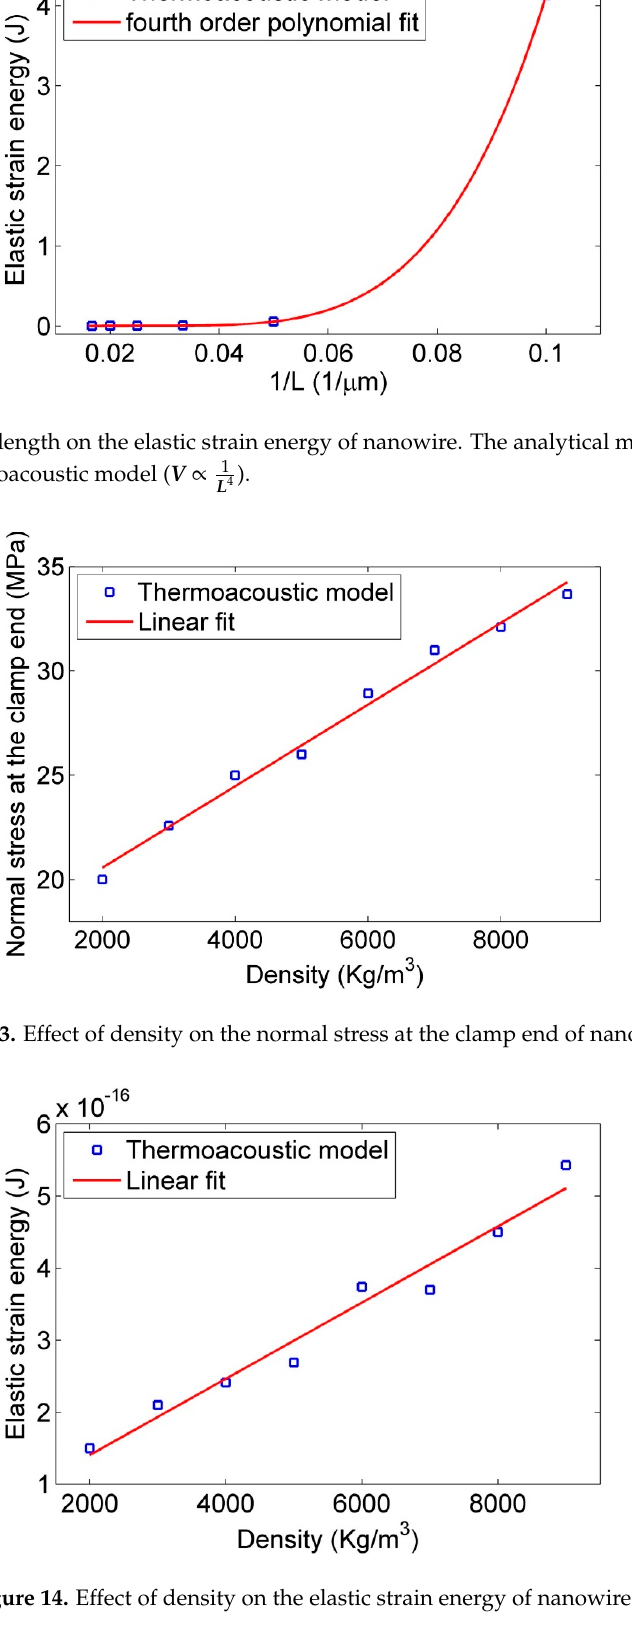
Figure 14. Effect of density on the elastic strain energy of nanowire.